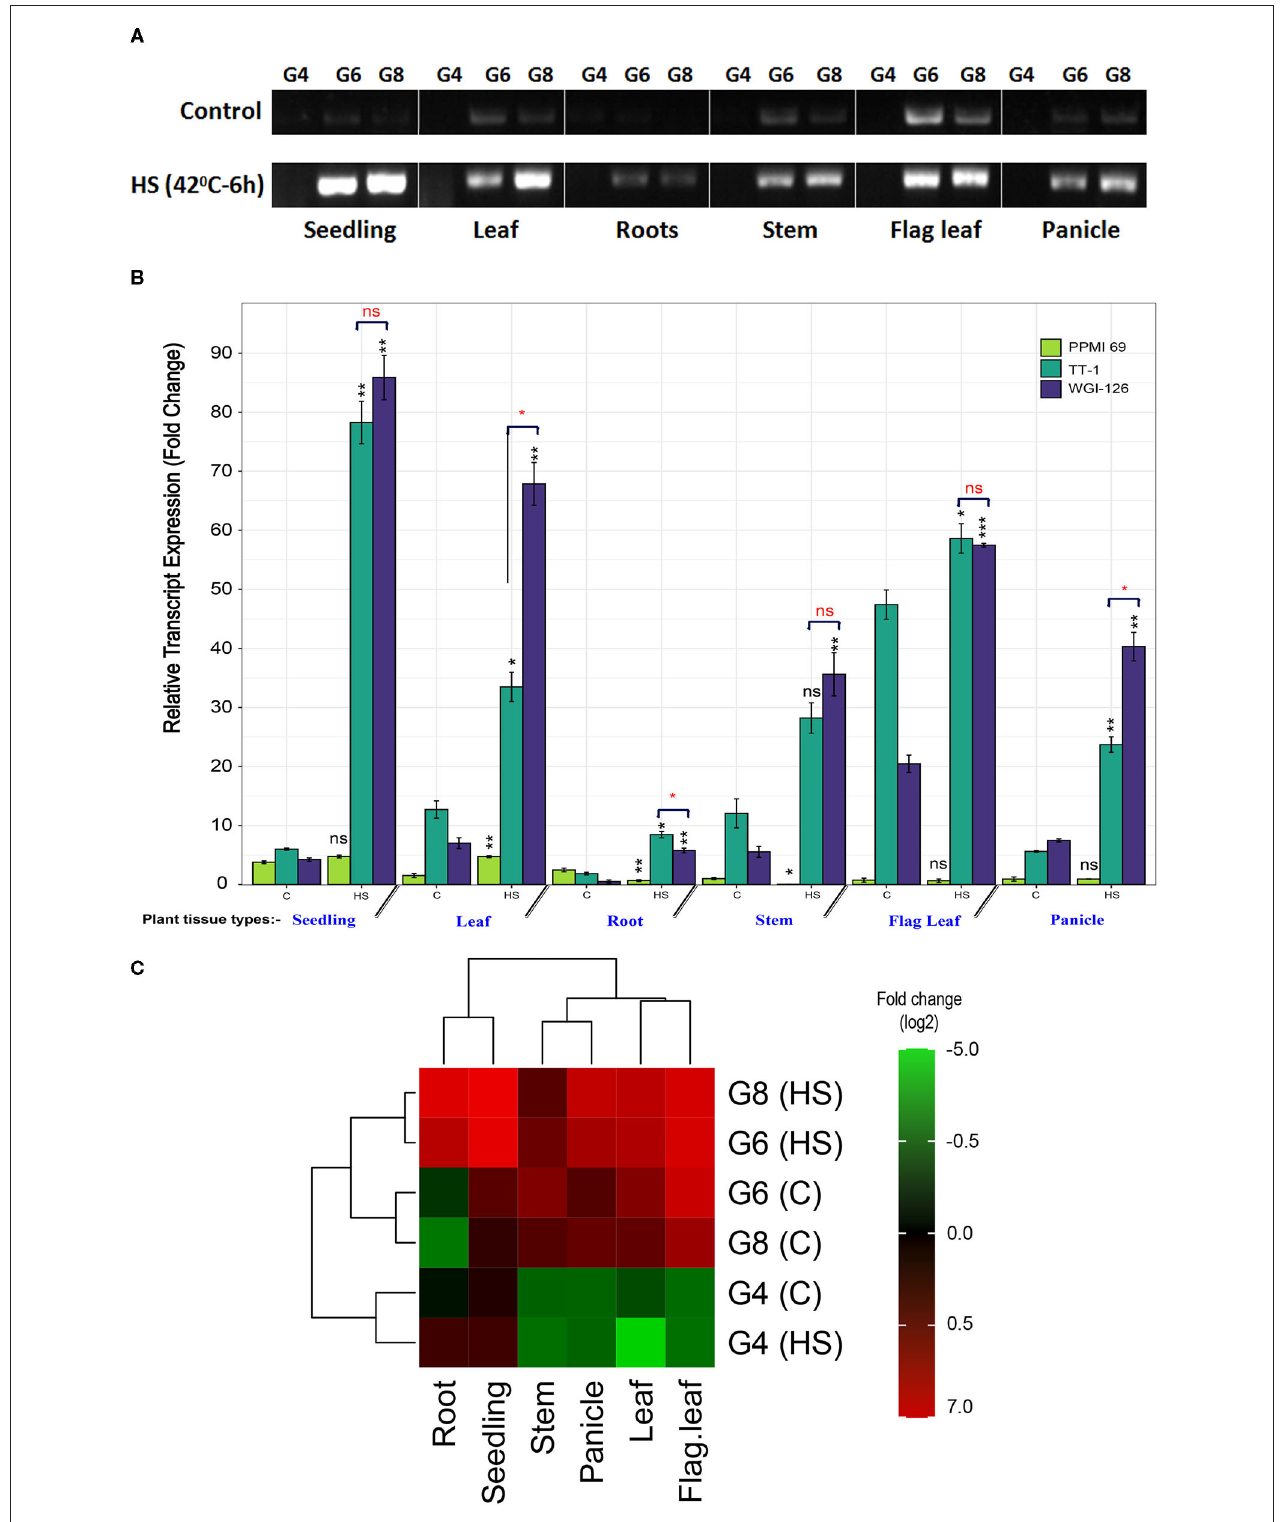
FIGURE 4 | (A) Semiquantitative RT-PCR profile of PgHSP16.97 transcripts after heat stress (HS) (42 ◦ C for 6h) on different plant tissues of the plant in three contrasting genotypes. The presented results are representative of at least three independent biological replicates. [PPMI-69 (G4), TT-1 (G6), and WGI-126